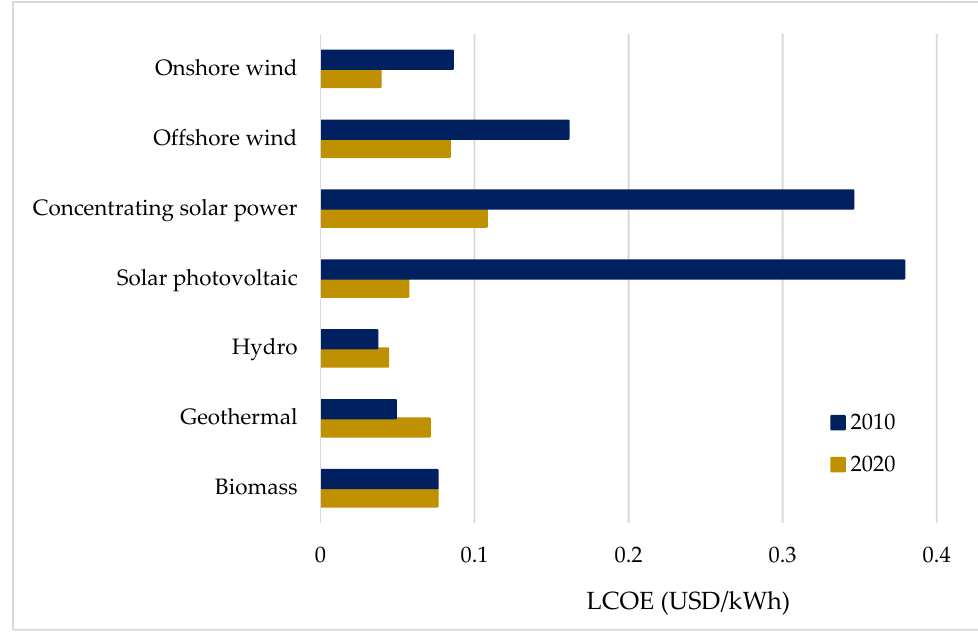
Figure 3. Global weighted-average LCOE of solar PV in 2010 and 2020. Reprinted with permission from Refs. [9,10]. Copyright 2020/2021 International Renewable Energy Agency.